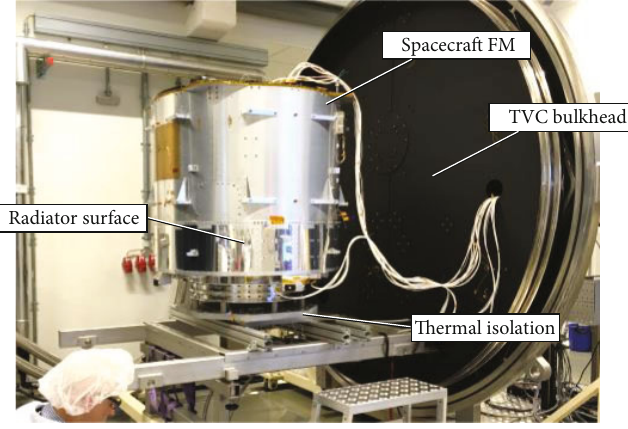
Figure 10: Radiator sizing during Thermal Balance